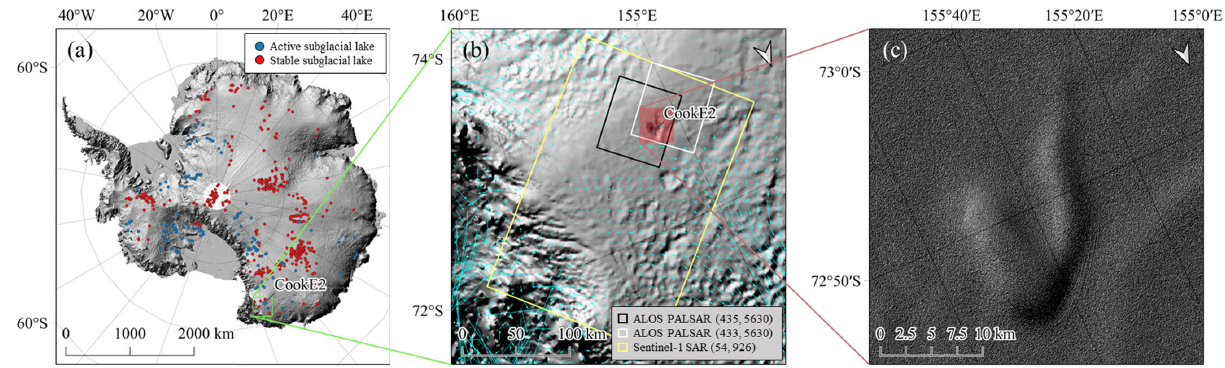
Figure 1. The study area. ( a ) shows the location of CookE2 in the inventory of subglacial lakes beneath the Antarctica ice sheet [1]; ( b ) is an enlarged area of the green rectangle of ( a ), and shows the area of the SAR image used in this study (black, white, and yellow rectangle). In the legend of ( b ), the numbers in parentheses mean path and frame numbers, respectively. The cyan arrows indicate the direction and relative flow velocity of the ice flow; ( c ) is an enlarged area of the red-colored rectangle of ( b ), a shaded relief image of the CookE2 based on Copernicus 30 m DEM [32]. All subsequent figures are displayed in the same area as ( c ).